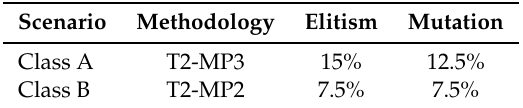
Table 4. Adjustment of the most rewarding elitism and mutation values for each particular scenario, for the methodologies selected. Values were obtained experimentally.